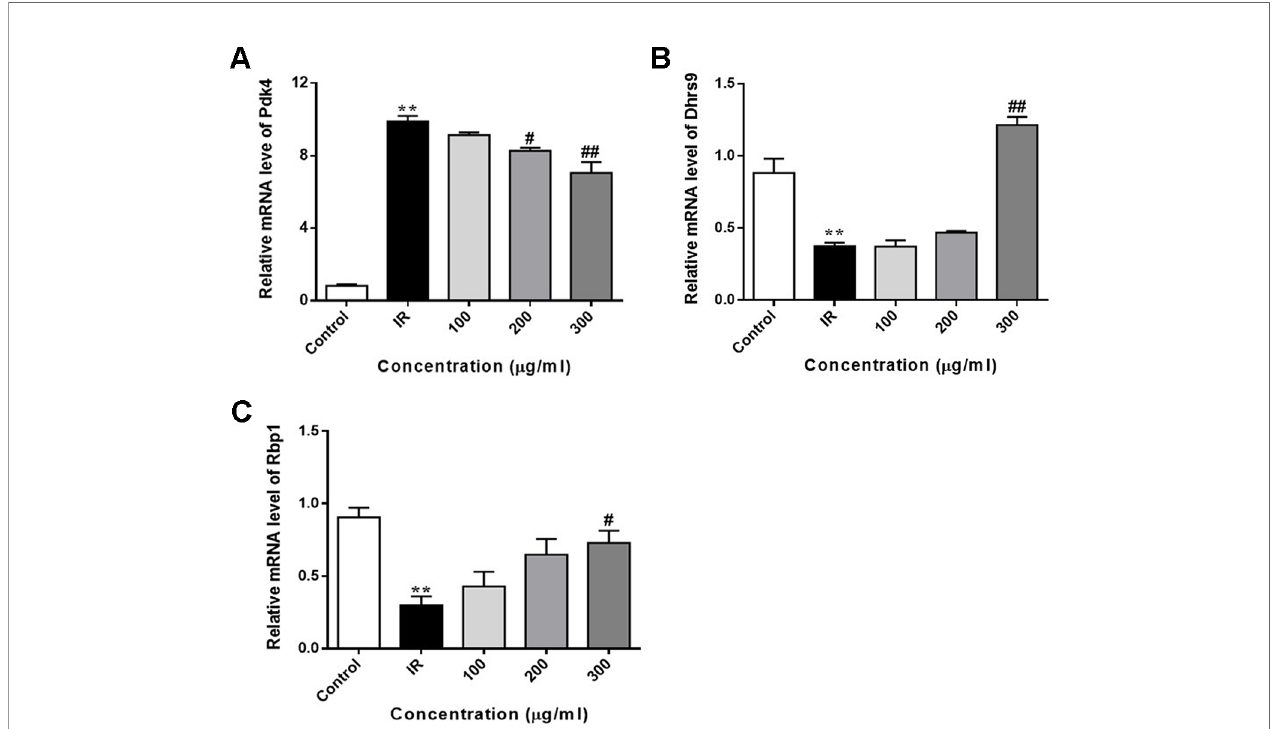
FIGURE 8 | WEE reversed PA induced changes of FoxO1 target genes in PA treated HepG2 cells. HepG2 cells were incubated with normal glucose (5.5 mM) or high glucose (30 mM) plus PA (0.3 mM) in the absence or presence of WEE (200 and 300 m g/ml) for 24 h and followed by being stimulated with insulin (100 nM) for 20 min. The mRNA levels of Pdk4 (A) , Dhrs9 (B) , and Rbp1 (C) were quanti fi ed by qRT-PCR. Data presented in bar charts are mean ± SEM values from three independent experiments. Groups are signi fi cantly different from the control group at **p < 0.01. The groups are signi fi cantly different from the IR group at # p < 0.05 and ## p < 0.01 determined by Dunnett ’ s multiple comparisons test.